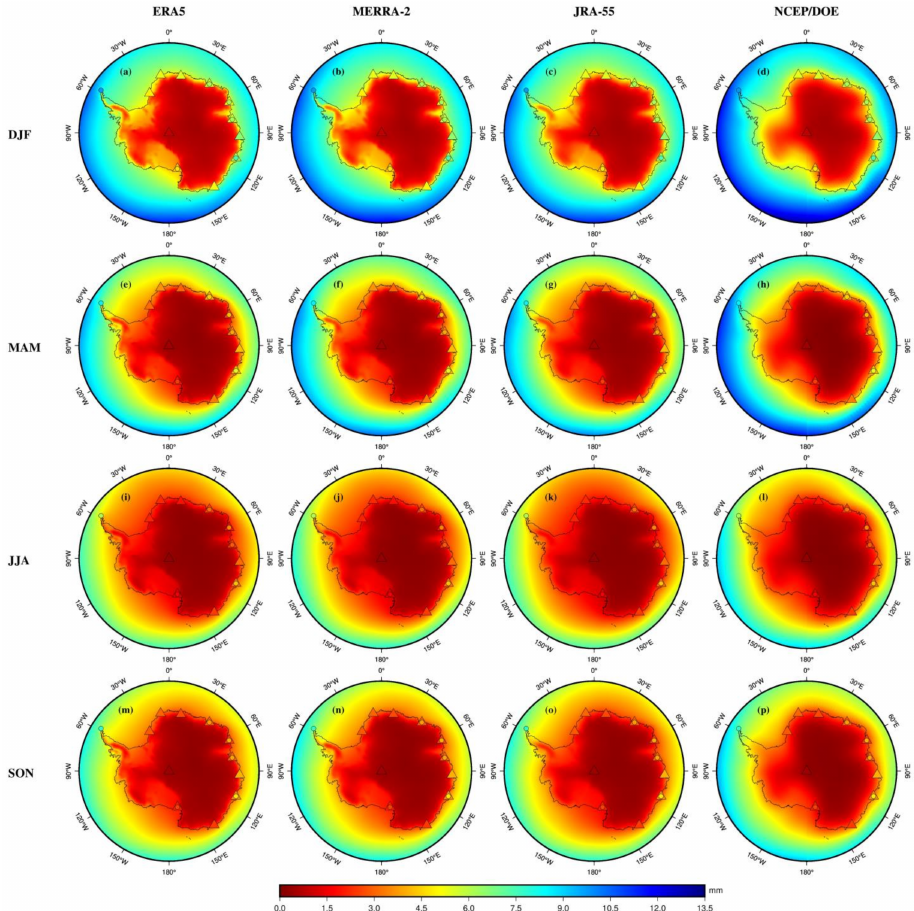
Figure 10. Spatial distribution of PWV means over Antarctica derived from ( a , e , i , m ) ERA5, ( b , f , j , n ) MERRA-2, ( c , g , k , o ) JRA-55, ( d , h , l , p ) NCEP/DOE reanalysis (color shading), GNSS (color circles) and radiosonde (color triangles) for the four seasons from 2001 to